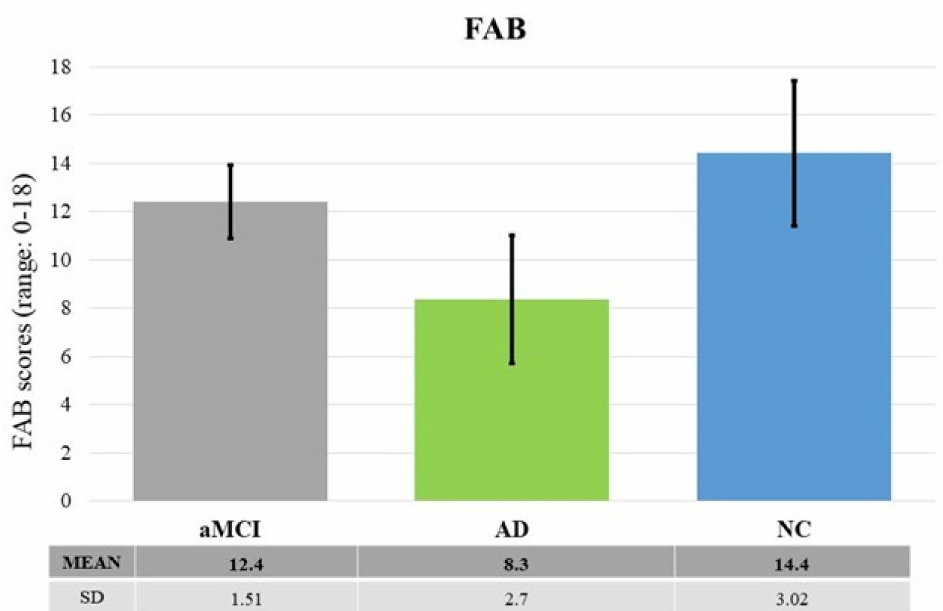
Figure 5. The graph shows the raw scores at FAB as a function of the three groups of participants (aMCI, AD and NC). The black lines represent the standard deviation. Descriptive statistics are also shown in the table below the graph.